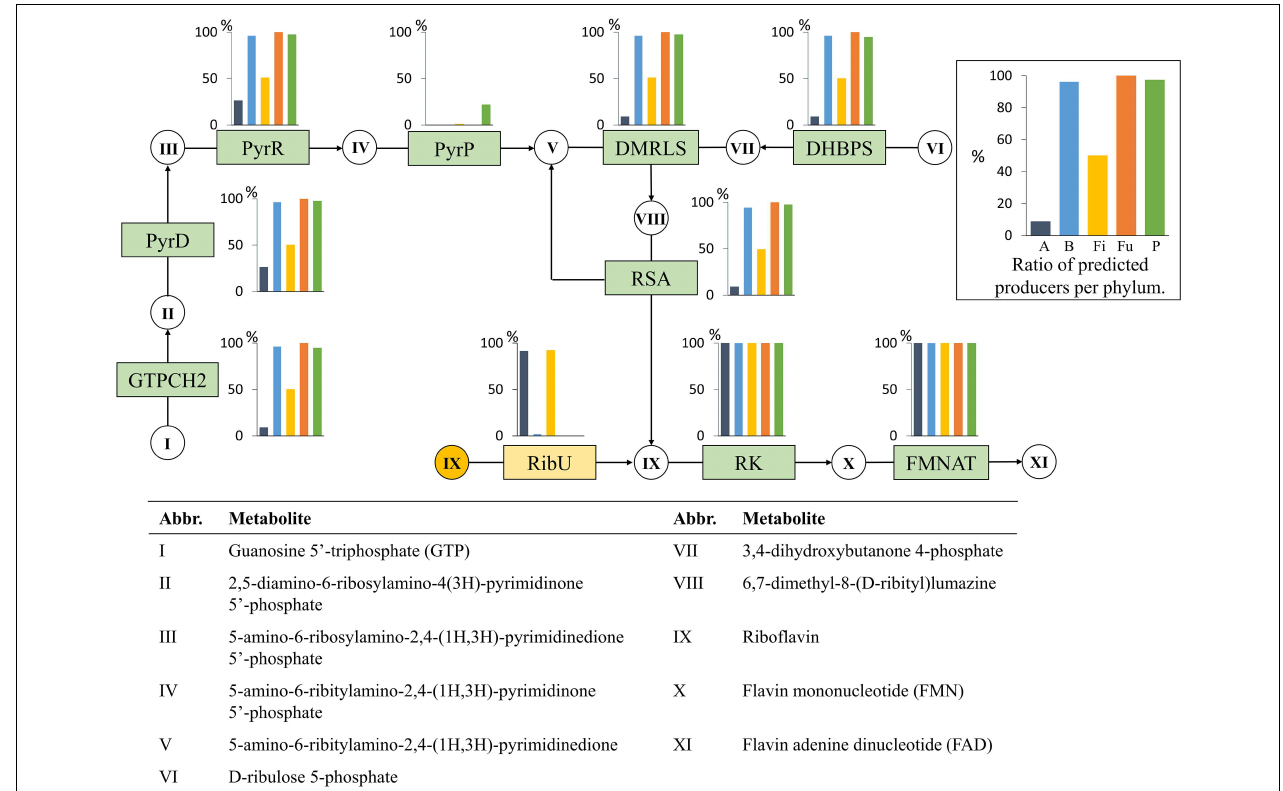
FIGURE 7 | Riboflavin biosynthesis. The riboflavin biosynthesis subsystem contains 10 functional roles (Supplementary Table 2) and 11 metabolites. Refer to Figure 1 for figure explanations.